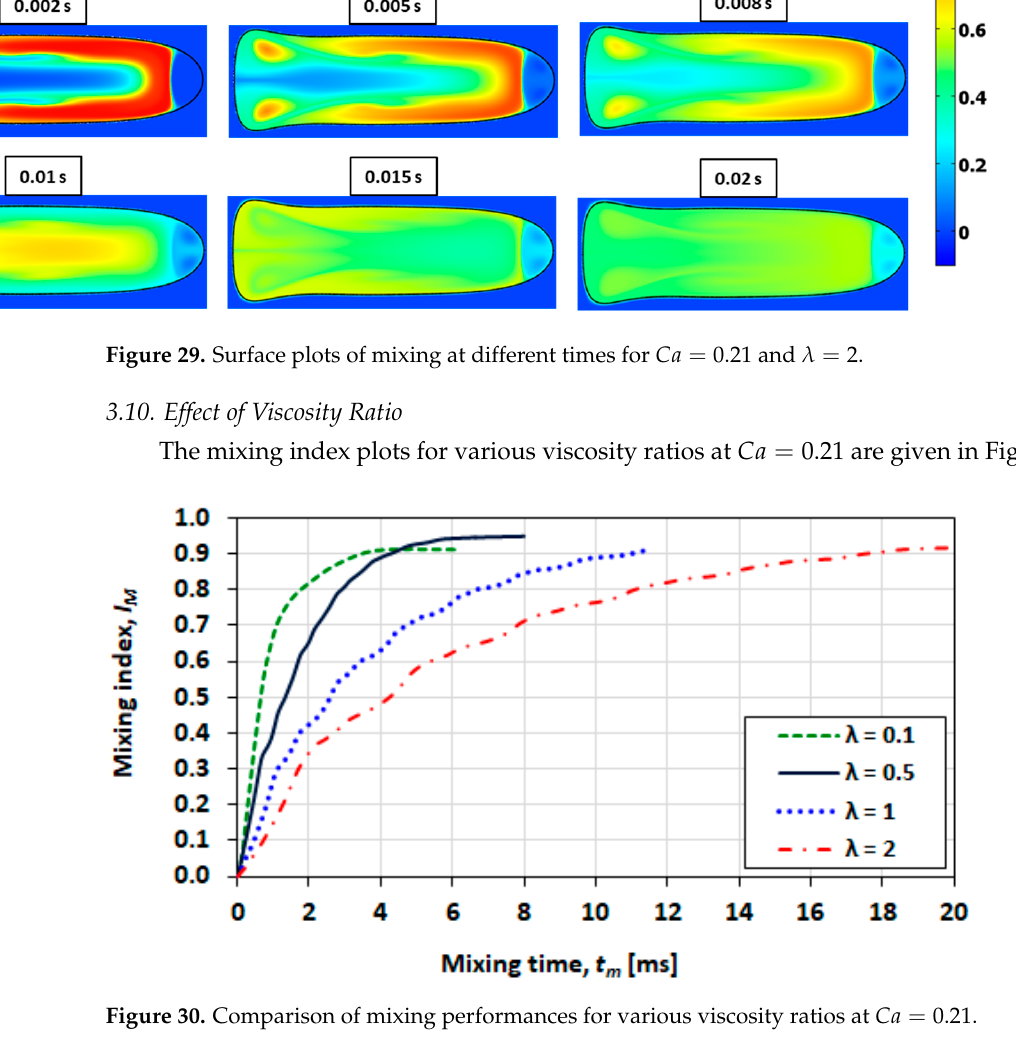
Figure 30. Comparison of mixing performances for various viscosity ratios at Ca = 0.21. The final mixing index of the case for λ = 0.5 is improved in comparison to that at λ = 0.1. These results are counterintuitive, and no explanation is provided for this observation, at present. Figure 31 shows mixing time and dimensionless mixing distance as a function of viscosity ratio at Ca = 0.21. The mixing time and the mixing distance both increase monotonically with the increasing viscosity